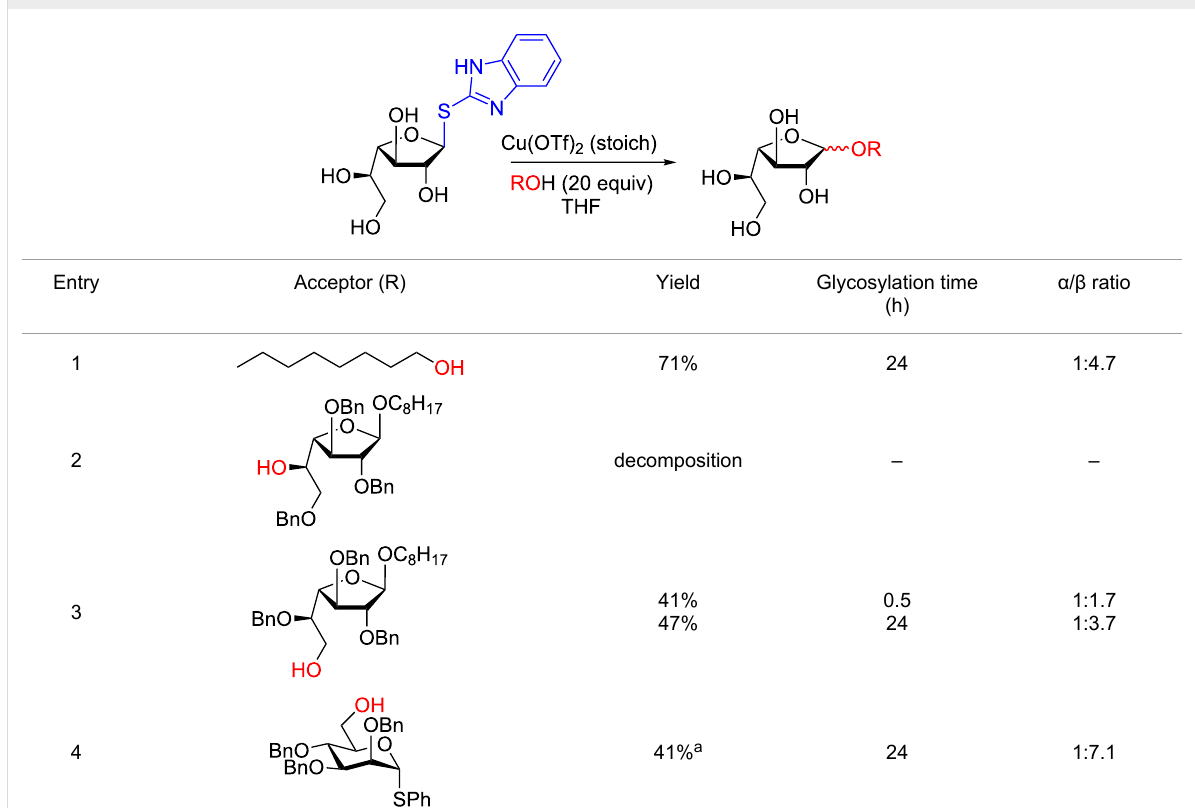
Table 2: Protecting-group-free O- glycosylation using a galactofuranosyl 2-thiobenzimidazole